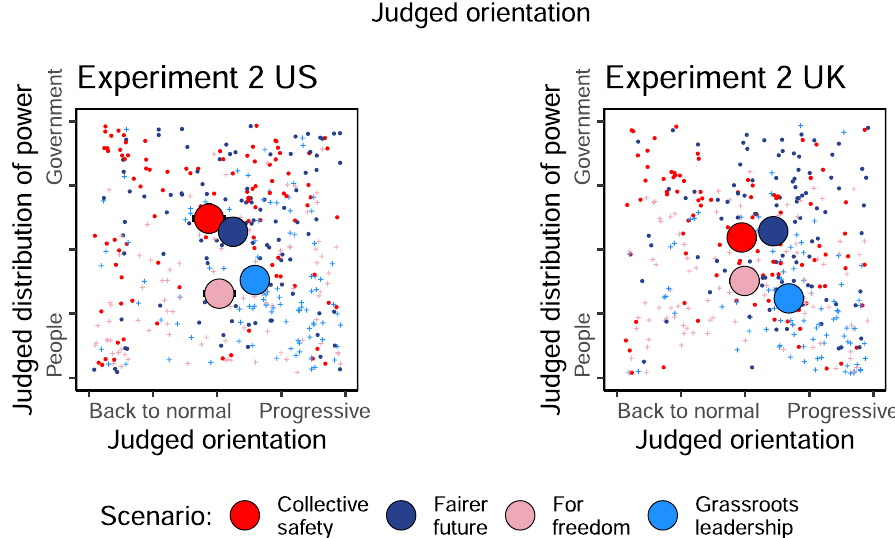
HUMANITIES AND SOCIAL SCIENCES COMMUNICATIONS| (2021) 8:296